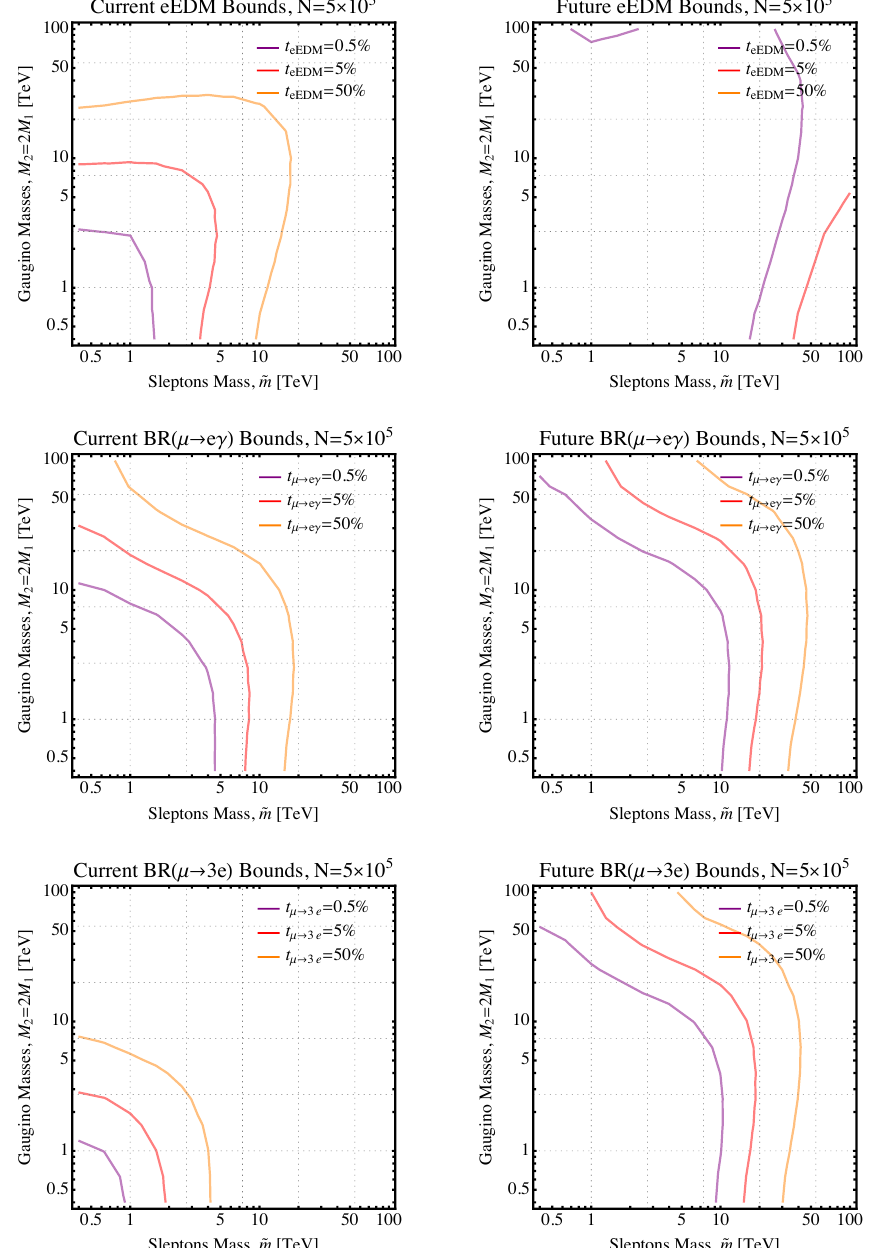
Figure 6 . Similar to figure 3 but for the charge assignment [ S 2 ] = − 2 and { [ L 1 ] , [ L 2 ] , [ L 3 ] , [¯ e ] , [¯ e ] , [¯ e ] } = { 3 , 2 , 2 , 4 , 1 , 0 } (the fourth row of table 1 2 3